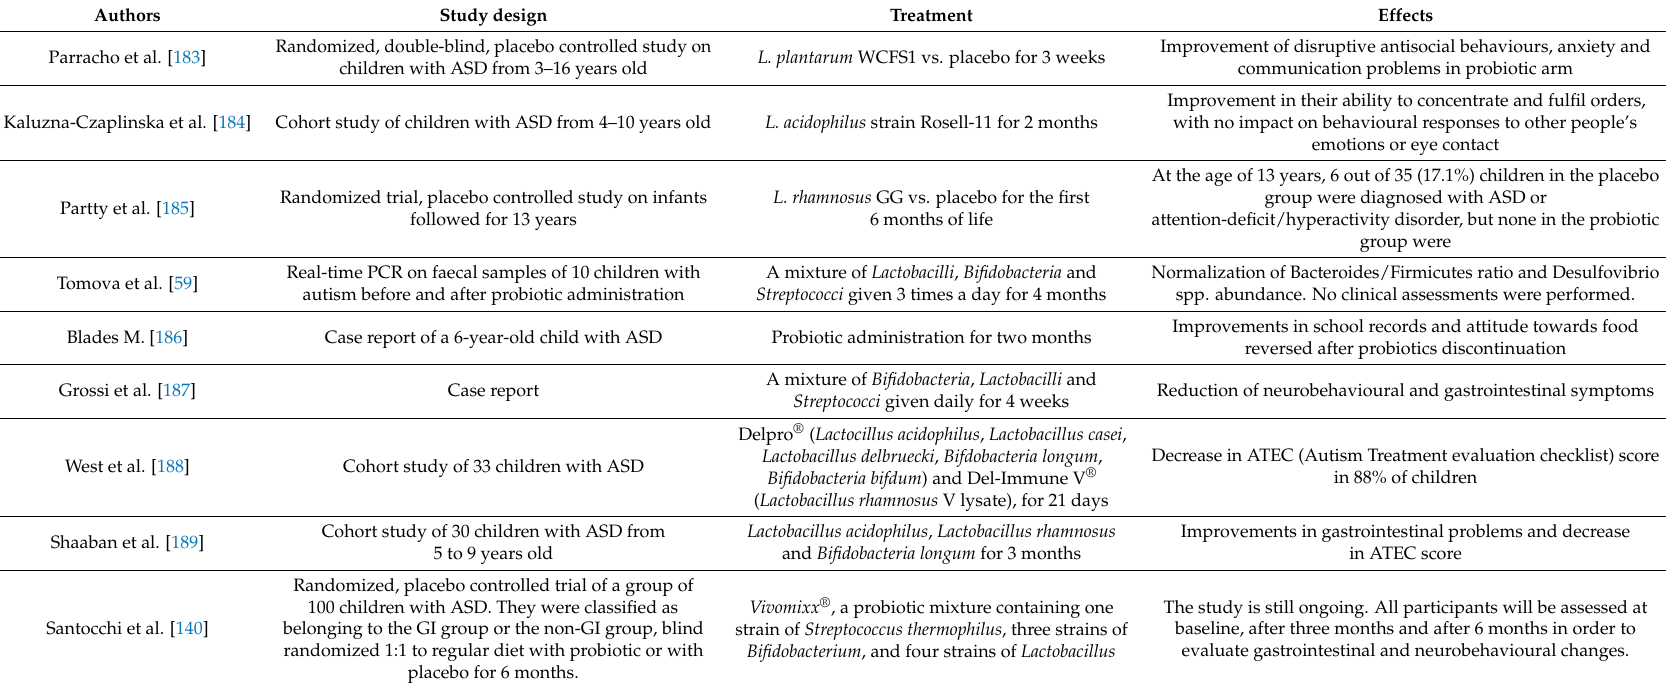
Table 1. Main clinical trials performed on the effects of probiotics on children with autism spectrum disorder